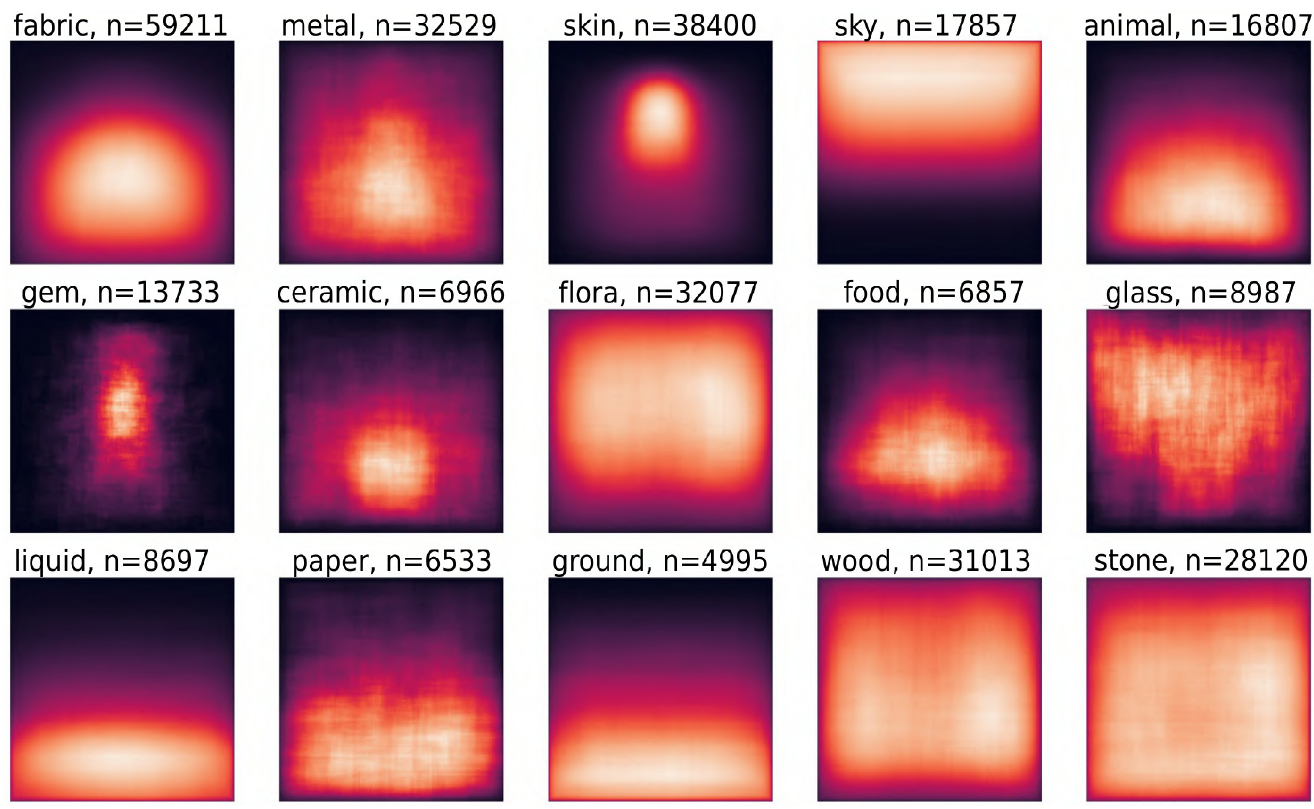
Fig 8. Material heatmaps, which illustrate the likelihood at any given pixel to find the target material at that pixel. Brighter colors indicate higher likelihoods.